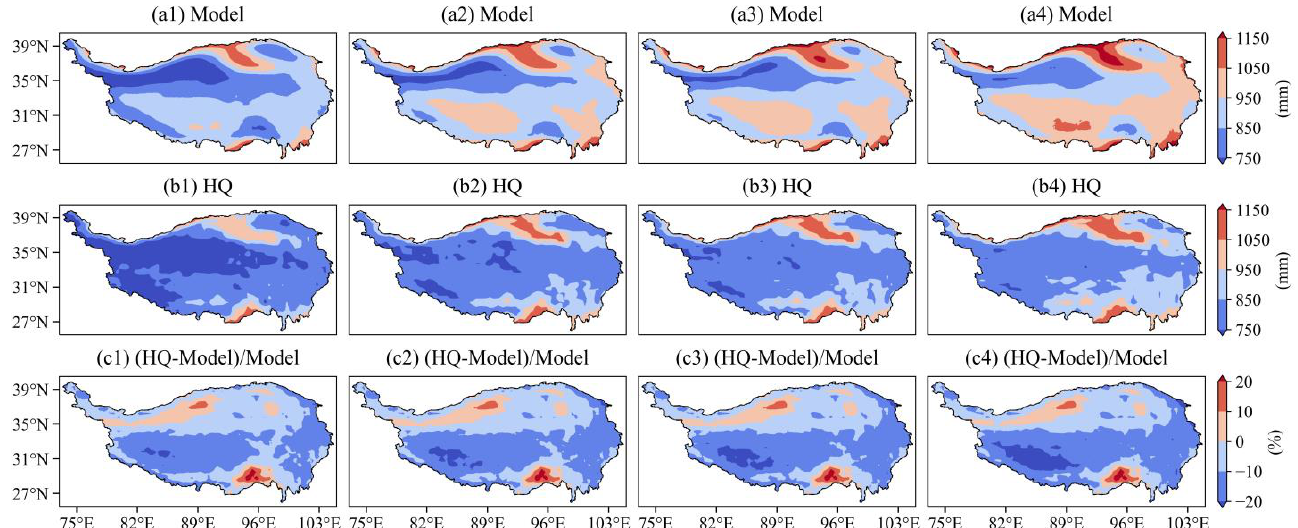
Figure 7. Spatial distribution and variation of annual mean PET before and after HQ correction. ( a – c ) are, respectively, the original, the HQ-corrected, and the variation between them. ( a1 – a4 ) are historical, SSP1-2.6, SSP2-4.5, and SSP5-8.5 scenarios, respectively. Then, we estimated three different forms of SPEI, including SPEI (uncorrected), SPEI (only TP corrected), and SPEI (TP and PET corrected) based on the run theory. Figure